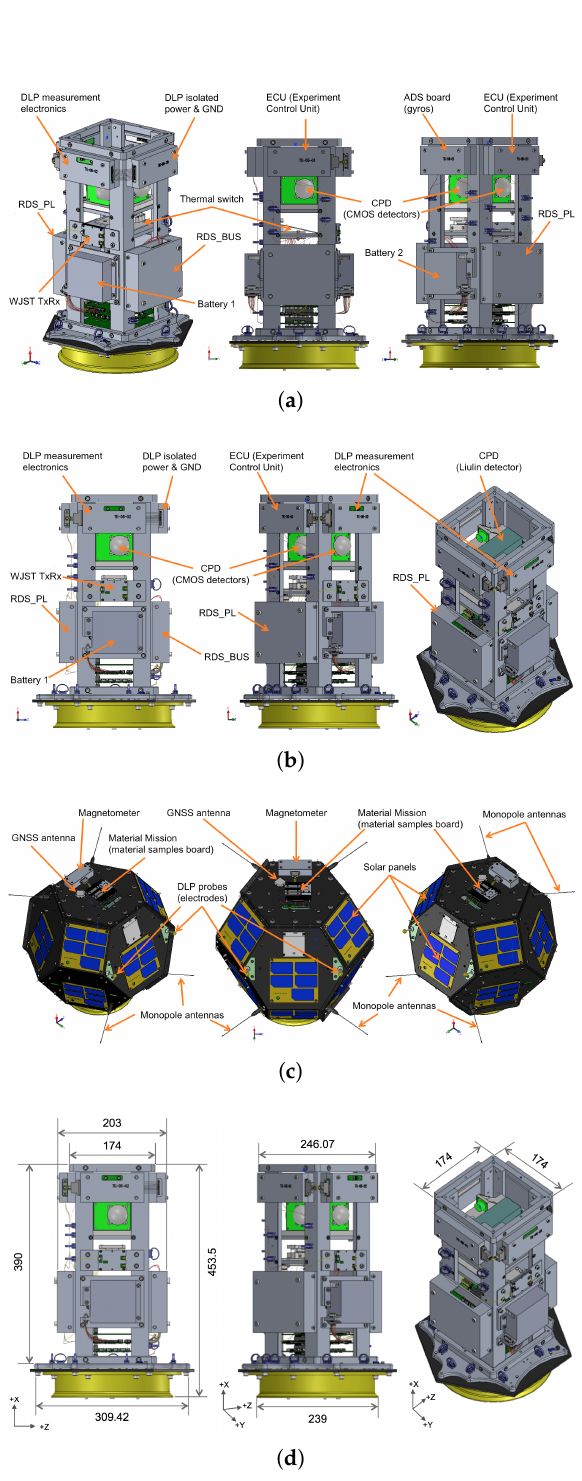
Figure 6. The payload arrangement onboard the spacecraft: external arrangement ( a ); internal arrangement ( b , c ); and internal structure dimensions in millimeters ( d